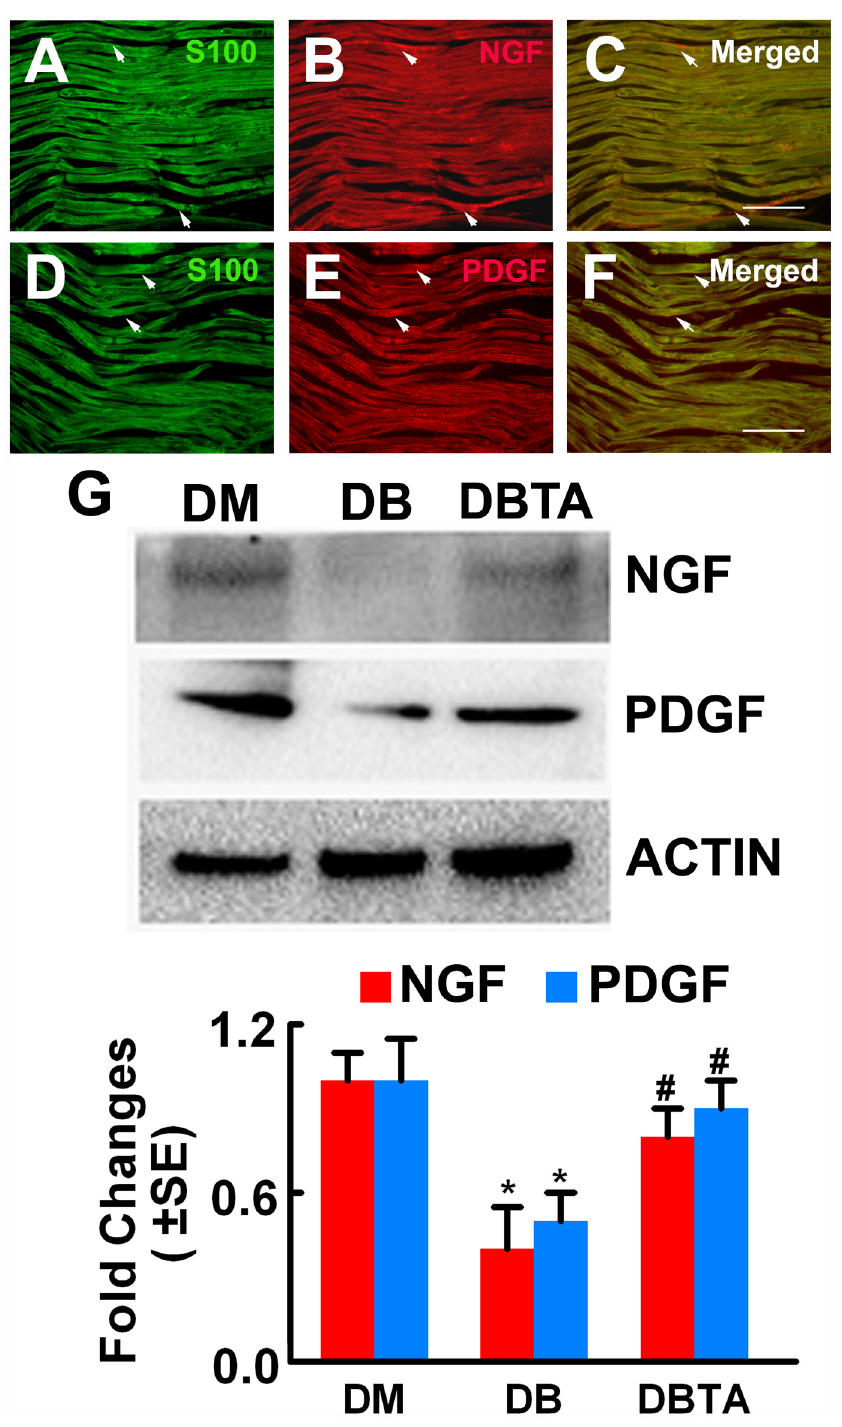
Fig 5. NGF and PDGF-C protein levels. Representative images of double immunofluorescent staining show that NGF and PDGF-C immunoreactivity (B, C, E, F, red, arrows) was co-localized to S100 positive Schwann cells (A, D, green, arrows). Western blot analysis (G) shows NGF and PDGF-C levels in the sciatic nerve tissue and β -actin was used as an internal control. * p < 0.05 and #p < 0.05 versus the non-diabetic mouse (DM) and the diabetic mouse treated with saline (DB), respectively. n = 6/group. Bar = 50 μ m. DBTA = diabetic mouse treated with